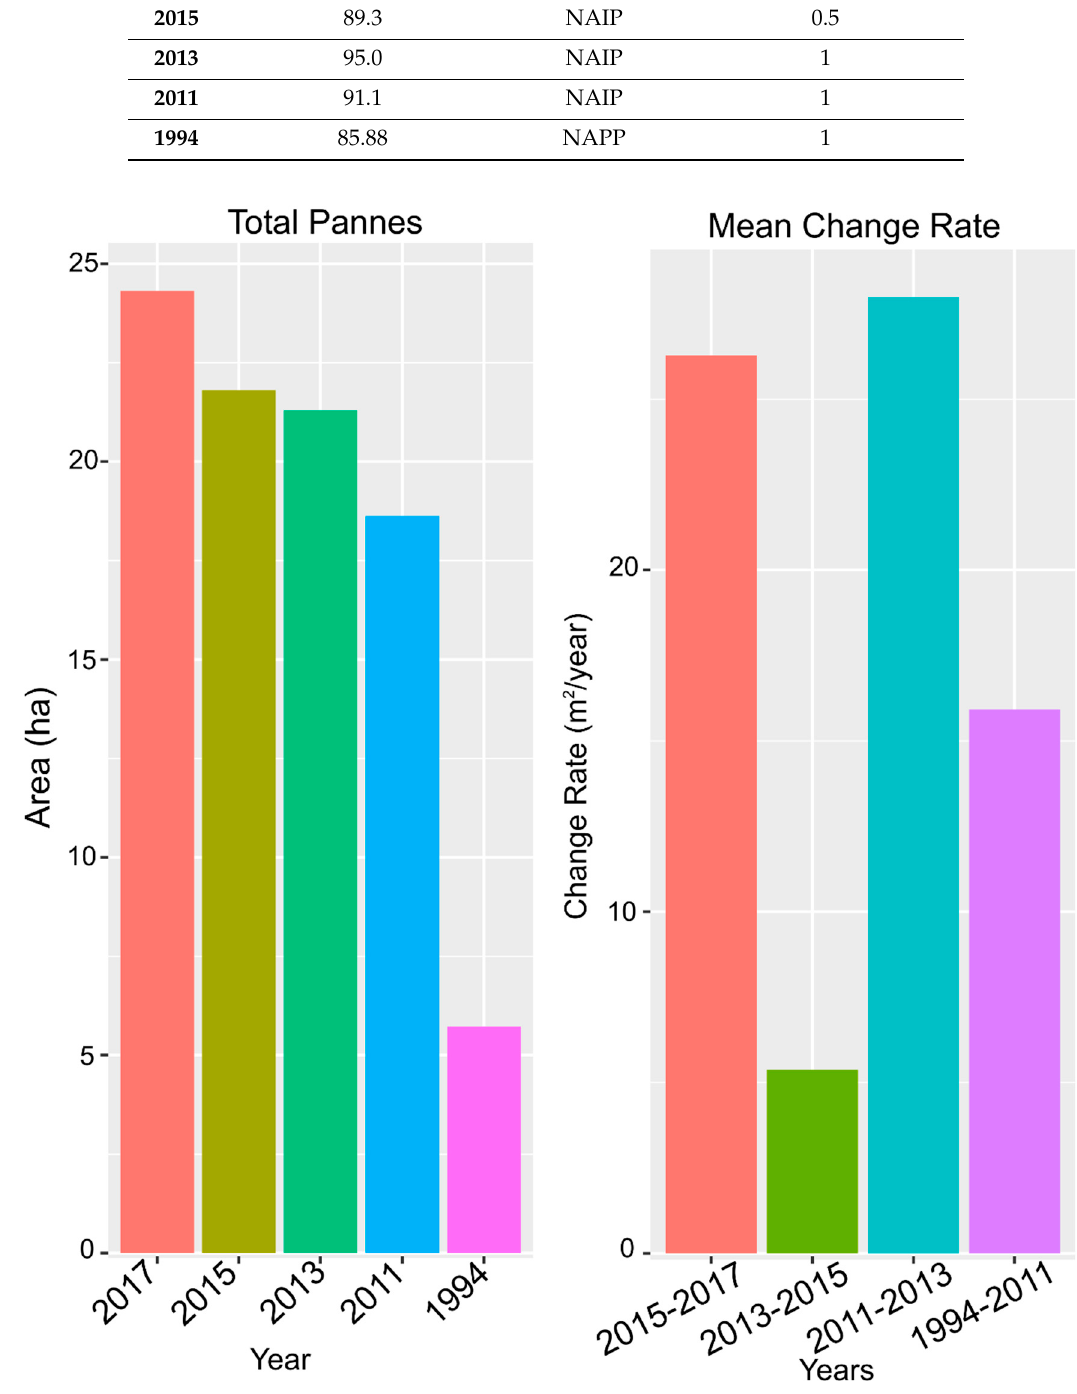
Figure 5. Interior pannes total area and change rates from (1994–2017) both the average yearly change rates of a time period and total area of pannes and pools.